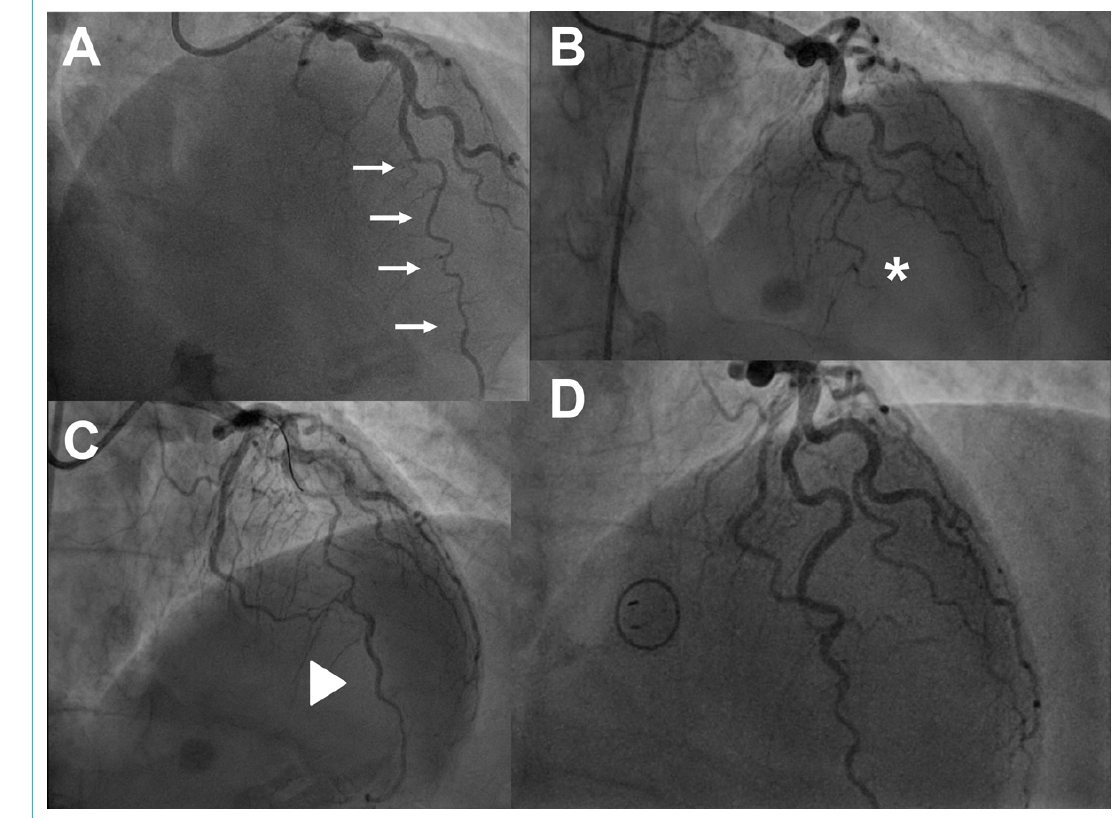
Figure 4: Serial angiograms of a 56-year-old woman with extensive spontaneous coronary artery dissection (SCAD) of the mid to distal left anterior descending artery (LAD; panel A, cranial view, as also in B-D, arrows highlighting the extent of the dissection). A decision for conserv- ative management was made at that time. The guiding catheter and the guidewire were used to optimise angiography but no percutaneous coronary intervention (PCI) was attempted. Panel B: emergency repeat angiogram 10 hours later because of ST-segment elevation myocar- dial infarction showing complete occlusion of the distal LAD (asterisk). The LAD was treated by PCI using balloon dilation and application of a drug-coated balloon with the aim of preventing secondary re-stenosis after injury to the vessel wall caused by balloon inflation. Panel C: result after PCI, triangle highlighting the re-opened LAD. Panel D: repeat angiography after 6 months showing an open LAD with minimal irregulari- ties of the vessel wall (see also table